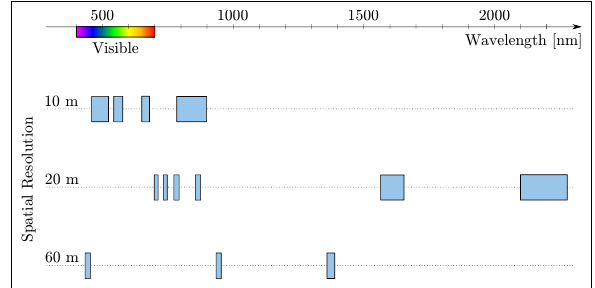
Figure 3: S ENTINEL -2 bands adapted from Sentinel-2 User Hand- book (2013) be significantly harder to distinguish because of increasing blur.